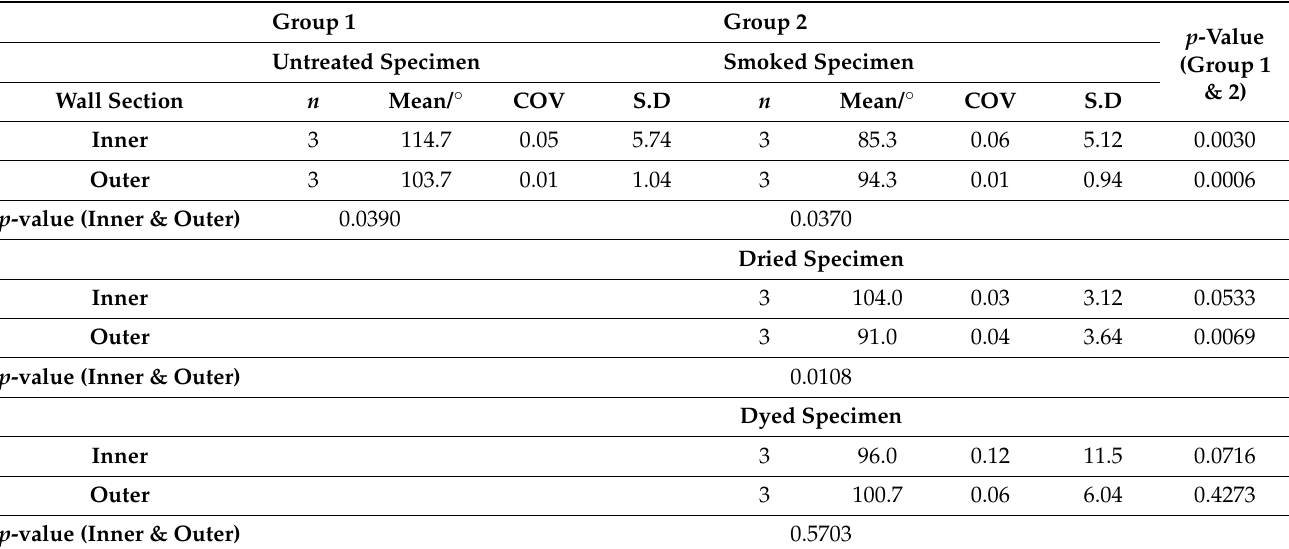
Table 3. Summary of p -values from unpaired t -test with a significance level of 0.05 to compare the contact angle results of inner and outer wall sections in and between each type of untreated and modified bamboo specimens.